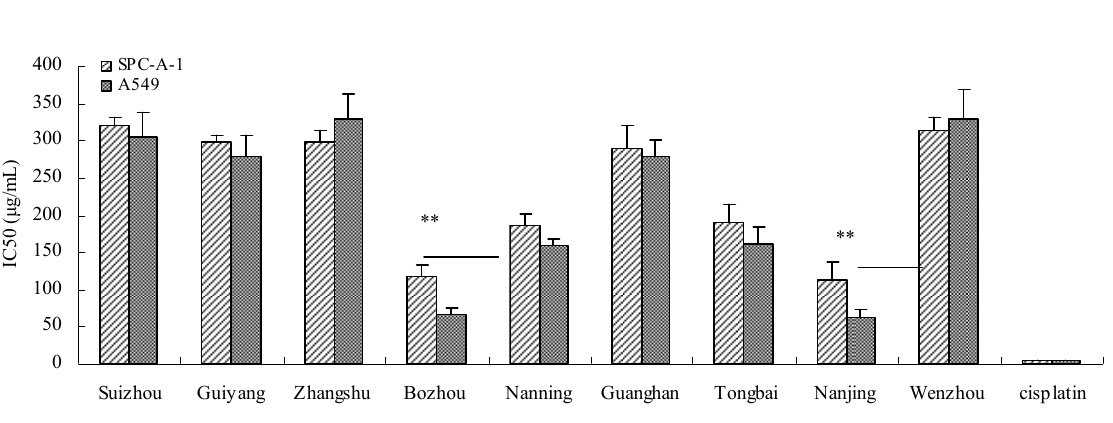
Figure 1. Proliferation inhibition activity of Prunella from different regions on A549 and SPC-A-1